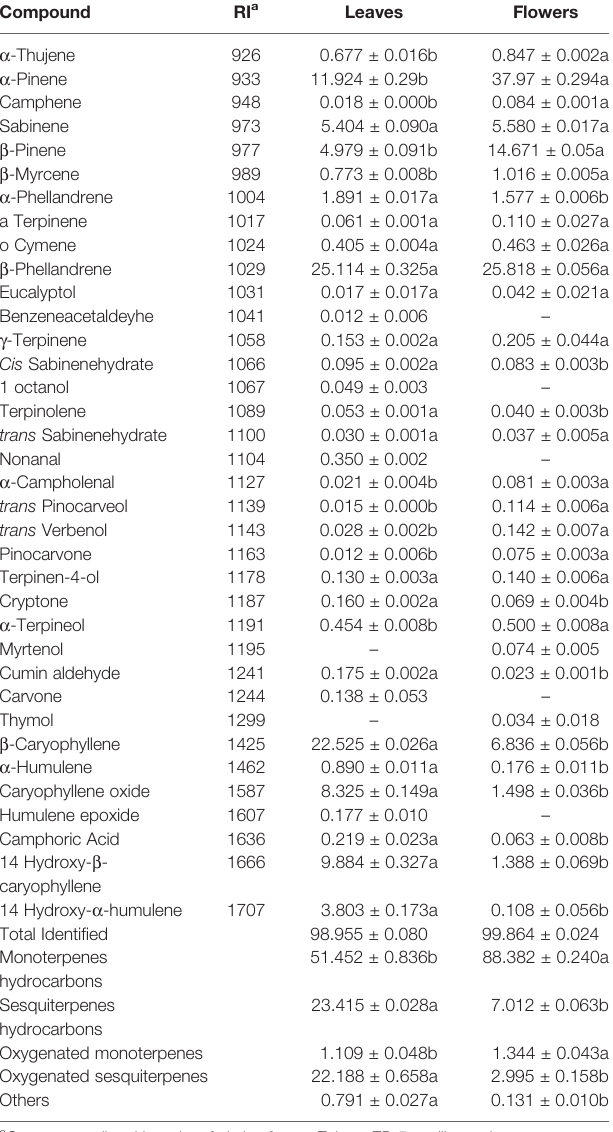
TABLE 3 | Chemical composition (%) of essential oils of Sideritis cypria leaves and fl owers.